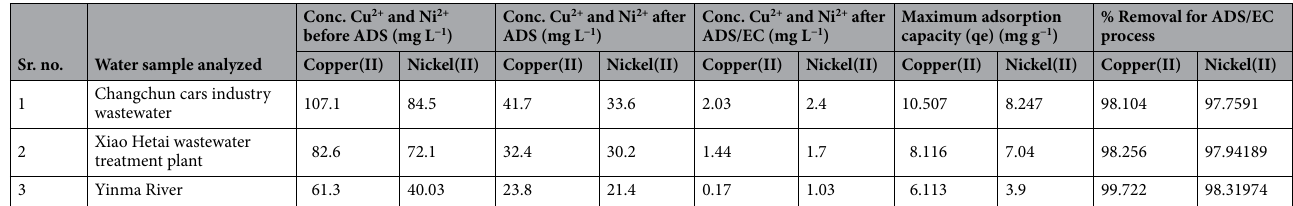
Table 3. Results of ADS/EC of Conc. Cu 2+ and Ni 2+ by AGWTR from different water samples.